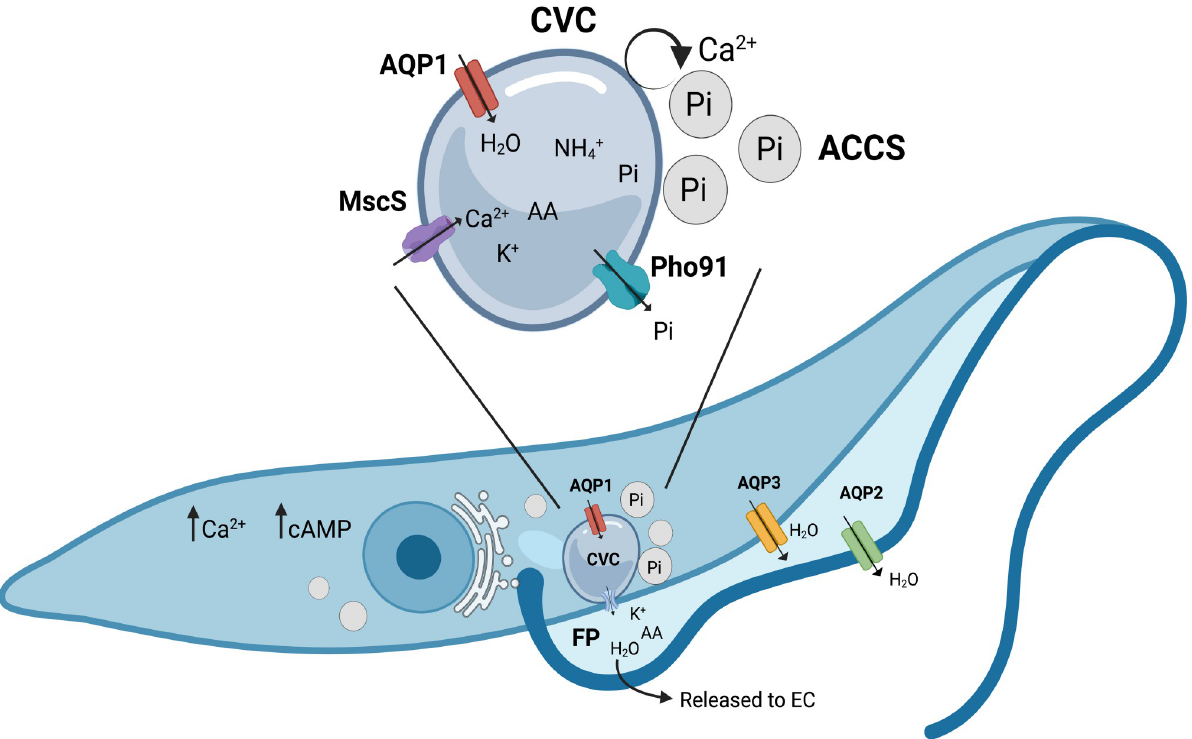
Fig 2. Mechanisms of osmoregulation in Trypanosoma cruzi . In T . cruzi , cell volume regulation is controlled by the CVC and the ACCS (reviewed in [247]). Both organelles are rich in ions accumulated by the activity of pumps located on their membranes. Upon hypoosmotic stress, ACCS fuse with the CVC transferring Pi, Ca 2+ , and AA. This concentration of osmolytes drives water into the vacuole via AQP1, causing swelling of the bladder that can be sensed by a mechanosensitive channel (MscS). Contact between the CVC membrane and the flagellar pocket induces the formation of a transient pore that mediates the discharge of water and osmolytes to the EC space. Some ions, like Pi, are not released but instead recovered by transporters (Pho1). These events are accompanied by increase in cAMP and a rise in cytosolic Ca 2+ required for volume recovery. Trypanosoma brucei does not possess a contractile vacuole and regulates cellular volume via aquaporins, with AQP2 residing in the flagellar membrane and AQP3 at the plasma membrane. Figure created with BioRender.com . AA, amino acid; ACCS, acidocalcisome; CVC, contractile vacuole complex; EC, extracellular; Pi,